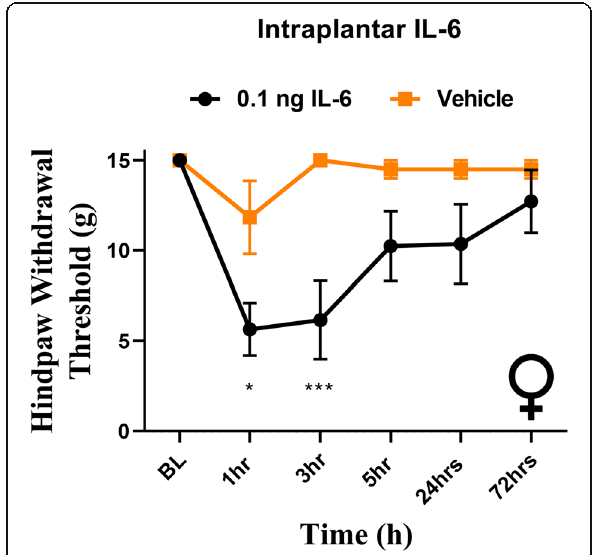
Fig. 2 Intraplantar IL-6 produces hindpaw hypersensitivity in females. Female rats from the cohort also shown in Fig. 3 had baseline hindpaw withdrawal thresholds established prior to receiving intraplantar injection of 0.1 ng IL-6. IL-6 ( n = 6) elicited significant effect of treatment on hindpaw hypersensitivity (F (5, 60) = 2.512, p = 0.0394) when compared with animals that received